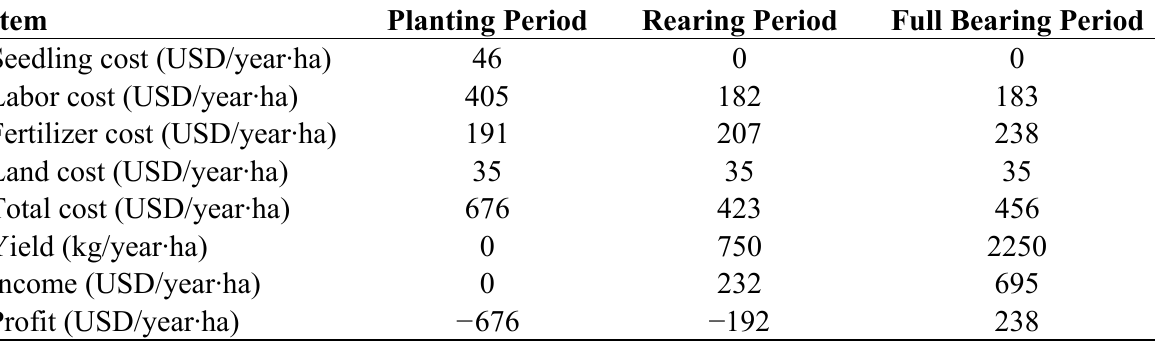
Table 6. Accounting of the inputs and outputs for a Jatropha